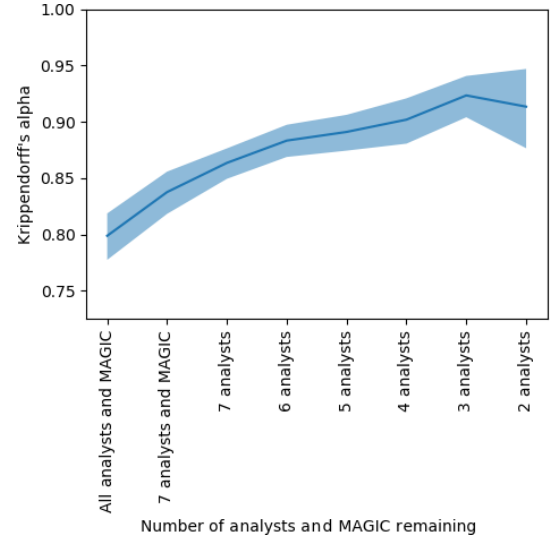
Figure 14. The agreement (Krippendorff’s alpha) found by sequen- tially removing each analyst or MAGIC algorithm from the group whose absence increased alpha the most. The vertical axis shows Krippendorff’s alpha. The horizontal axis shows the number of an- alysts and MAGIC remaining in the group considered – that is, the first entry on the left shows the Krippendorff’s alpha when all eight analysts and MAGIC were included, the second entry shows Krippendorff’s alpha when the analyst whose estimates disagreed the most was removed, etc., until only the two analysts whose ice concentration estimates that agreed the most with one another re- mained. The shaded region indicates the upper and lower bounds of the 95% confidence intervals.